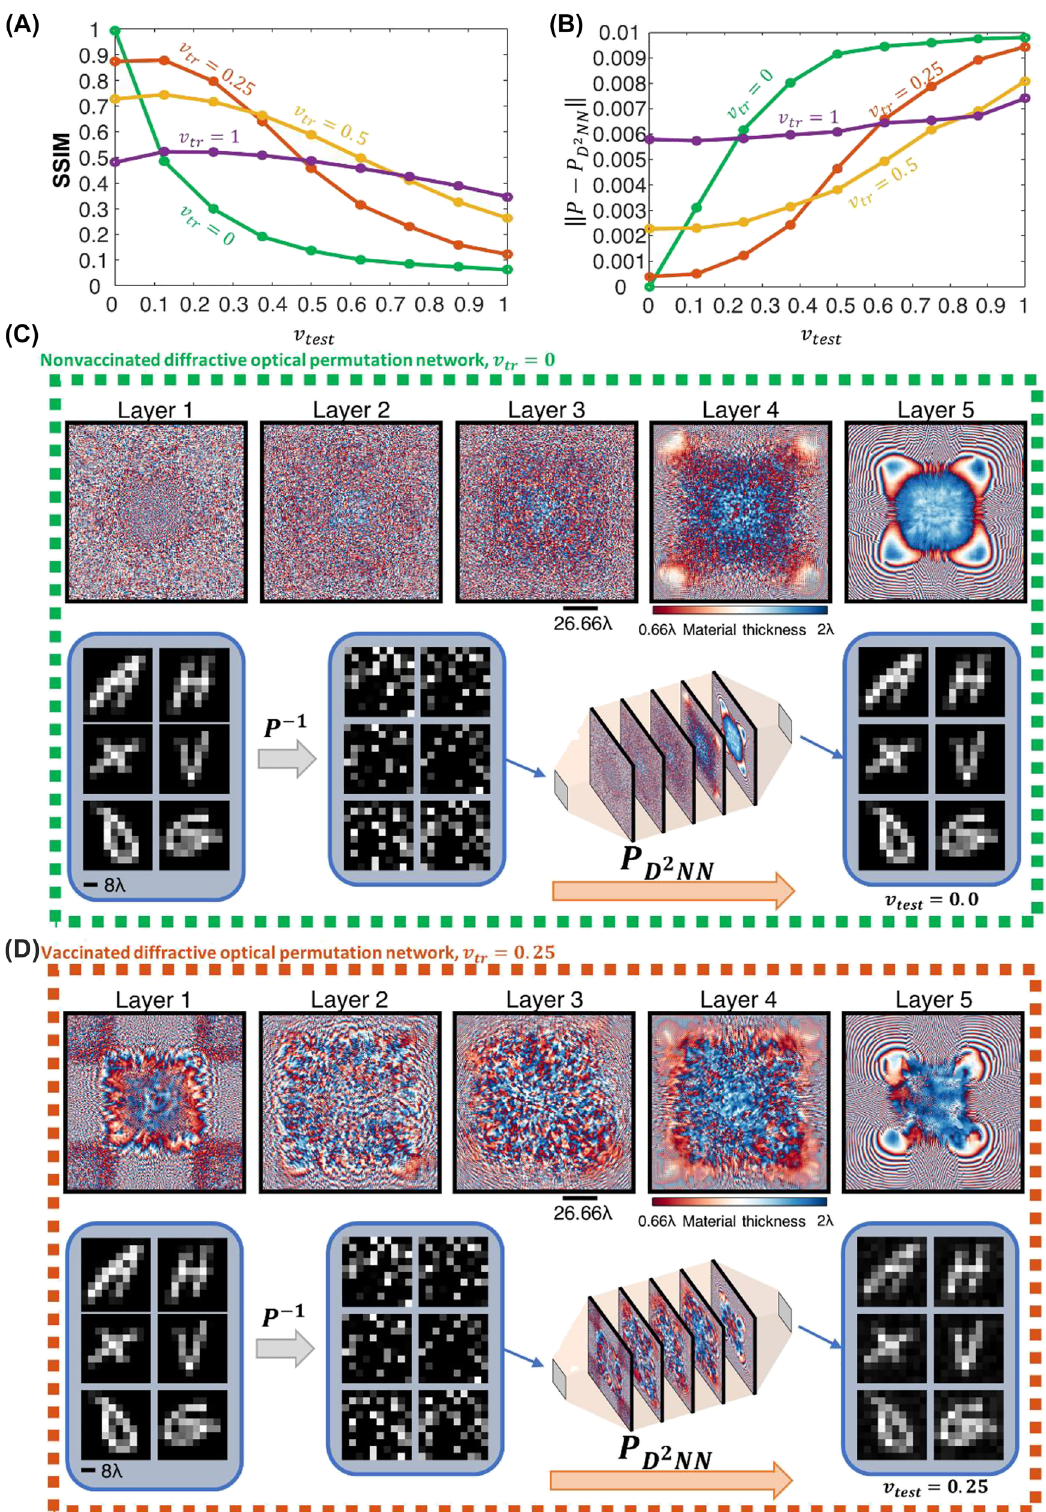
Figure 4: The sensitivity of the diffractive permutation networks against various levels of physical misalignments (A) SSIM values achieved by 5-layer diffractive permutation networks with and without vaccination. (B) Transformation errors between the desired 100 × 100 permutation operation ( P ) and its optically synthesized counterpart ( P D 2 NN ) at different levels of misalignments denoted by 𝑣 layers of a nonvaccinated diffractive permutation network, i.e., 𝑣 through the diffractive permutation operation. (D) Same as (C), except for a vaccinated diffractive permutation network based on 𝑣